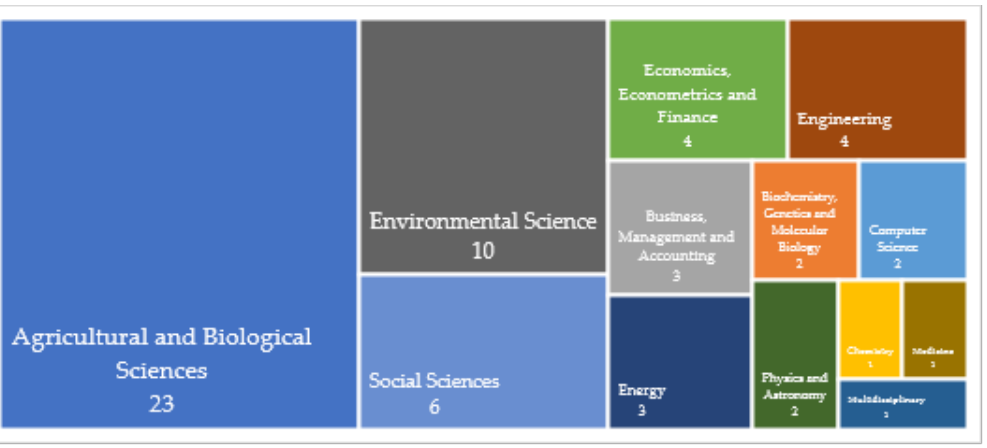
Figure 4. Number of papers per subject area of the journal. (Source: our elaboration.). The studies analyzed in this review were carried out worldwide (Figure 5). The majority of research was conducted in Australia (6 studies) and in European countries, specifically in Spain (6 studies). Developing countries are also well represented with case studies conducted in South America, East Asia, West and East Africa.